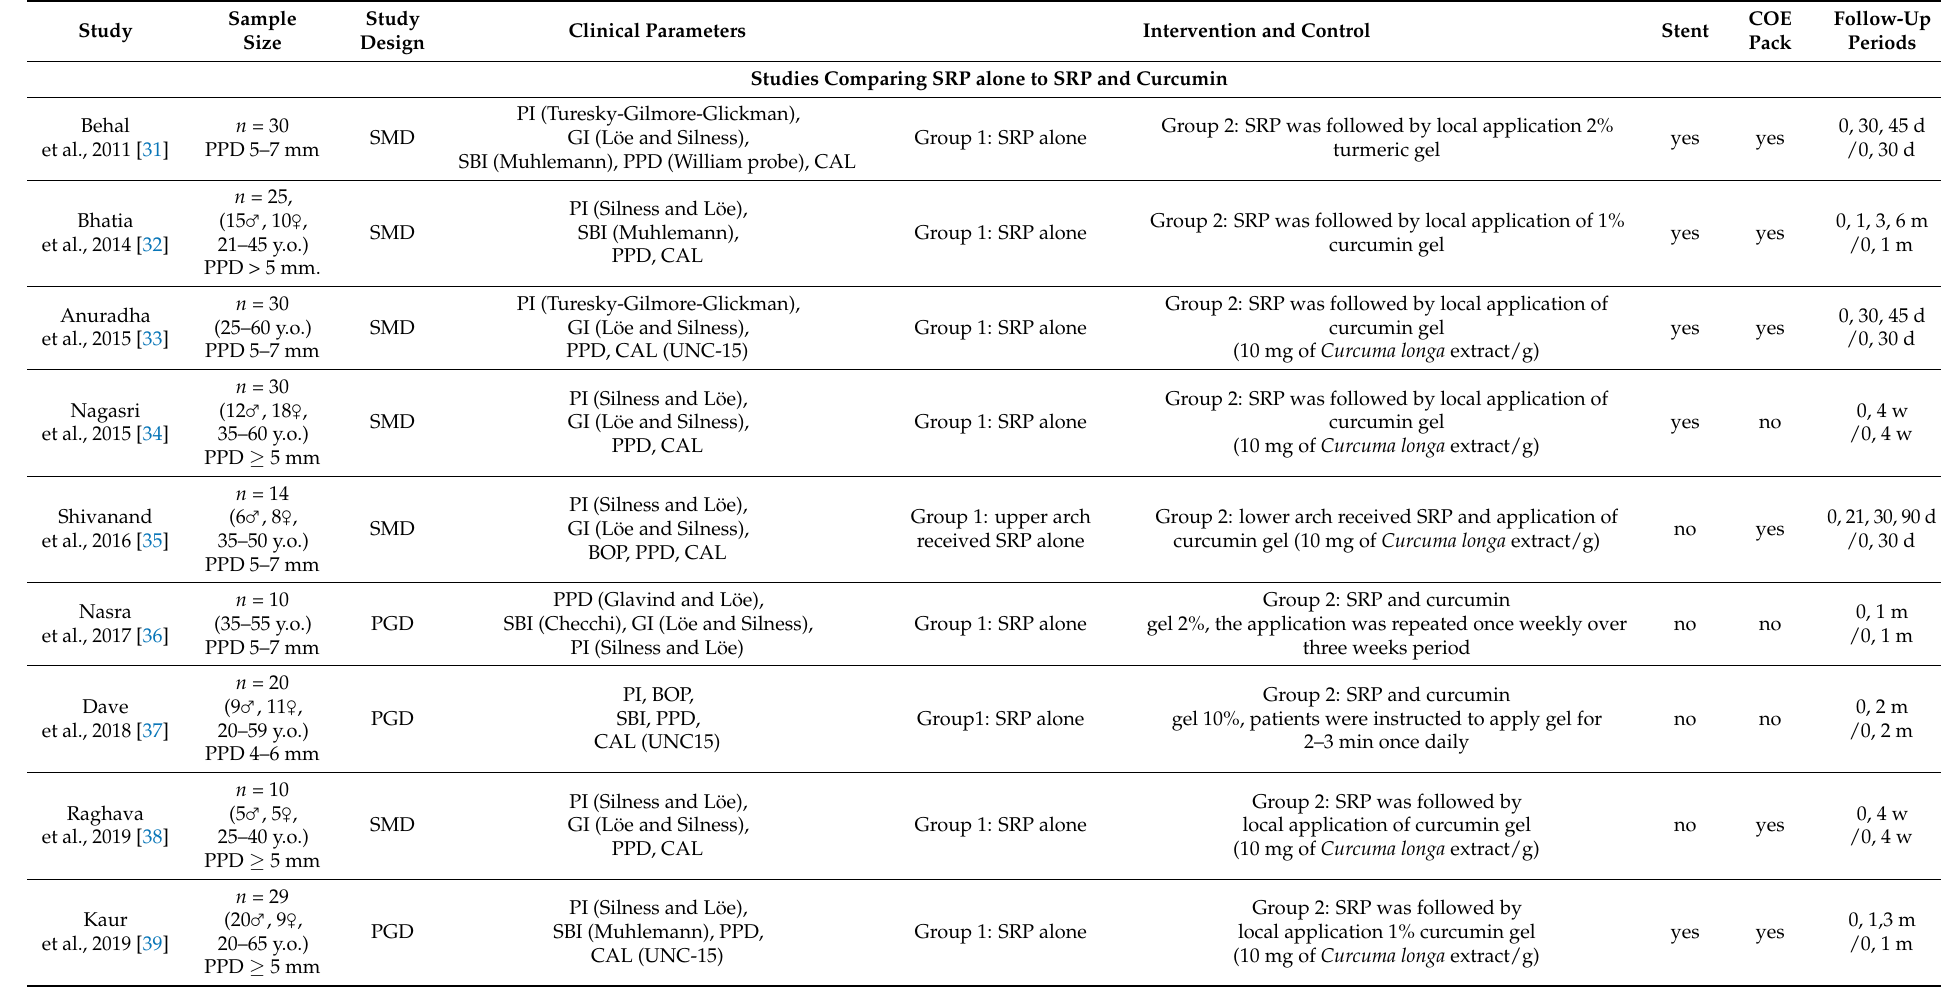
Table 1. Characteristics of included studies. SMD: split-mouth design, PGD: parallel-group design PPD: probing pocket depth, SBI: sulcus bleeding index, PI: